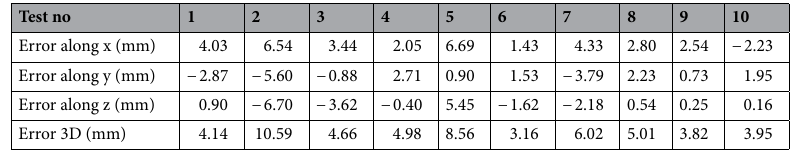
Table 1. Positioning errors on each axis and 3D Euclidean error. More details on error calculation are provided in Supplementary Material C. Axis (z) corresponds to the central axis of the ultrasonic cone, oriented positively towards the transducer.